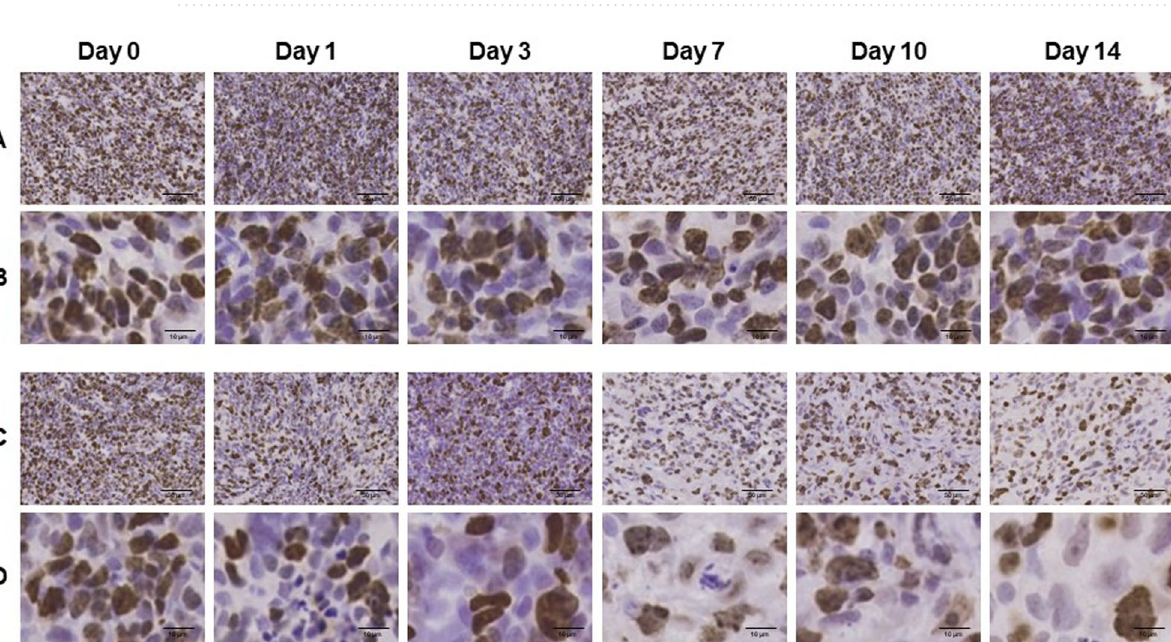
significantly decreased at day 3. However, this accumulation was transiently increased at day 7, and then was significantly decreased at day 10 and 14 as compared with that in the control (Fig. 6C).